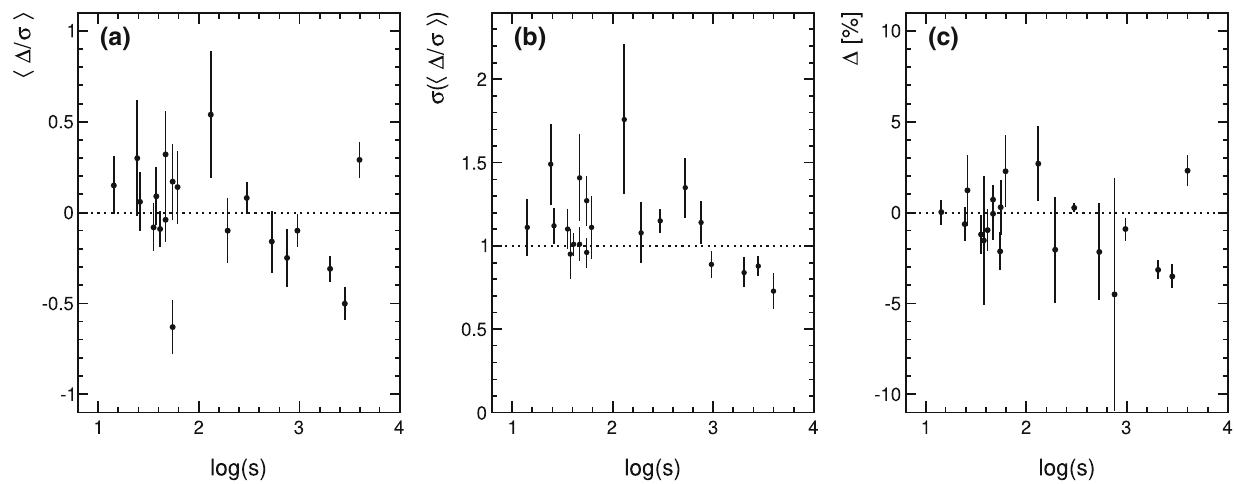
Fig. 41 a Mean deviation (cid:4) Δ/σ (cid:5) from the global interpolation per experiment as a function of log ( s ) , b variance of the Δ/σ distributions as a function of log ( s ) , c mean value of the percent deviation between the experimental results and the global interpolation as a function of log ( s )